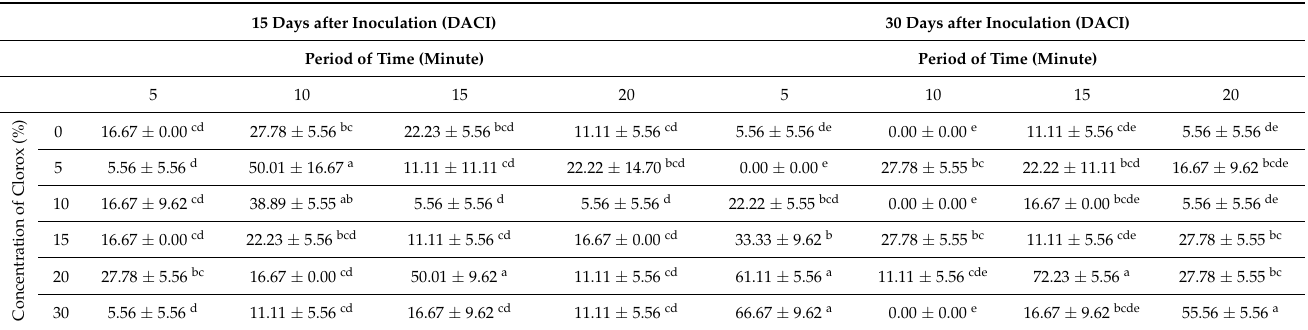
Table 7. Effect of different concentrations of Clorox used as a surface sterilizing agent for different periods of time on decontamination of stevia explants (%).